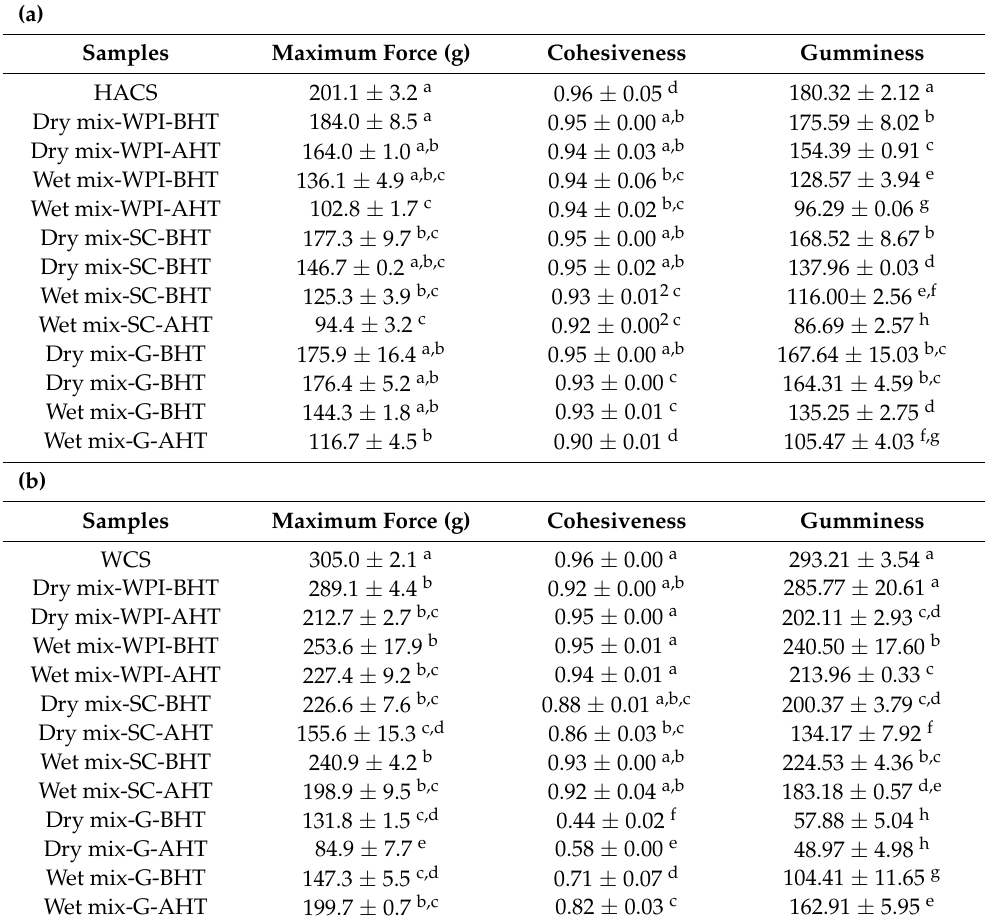
Table 2. ( a ) Texture properties of the corn starch with high amylose (HACS) control and protein- modified HACS before and after DHT. ( b ) Texture properties of waxy corn starch (WCS) control and protein-modified waxy corn starch before and after